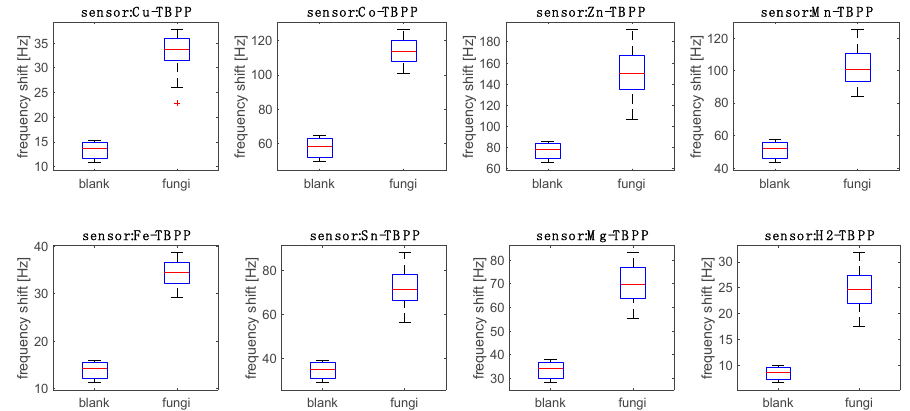
Figure 4. Distribution of the sensor responses to uncontaminated culture media and media inoculated with fungi. Each group contains data obtained at days 3, 5, and 10 after the first inoculation. The distribution of the responses is represented by a box-plot calculated with the Matlab embedded function. In each box, the central mark is the median, the edges are the 25th and 75th percentiles, the whiskers extend to the most extreme data points not considered outliers. Outliers, labeled with a cross, are plotted individually.